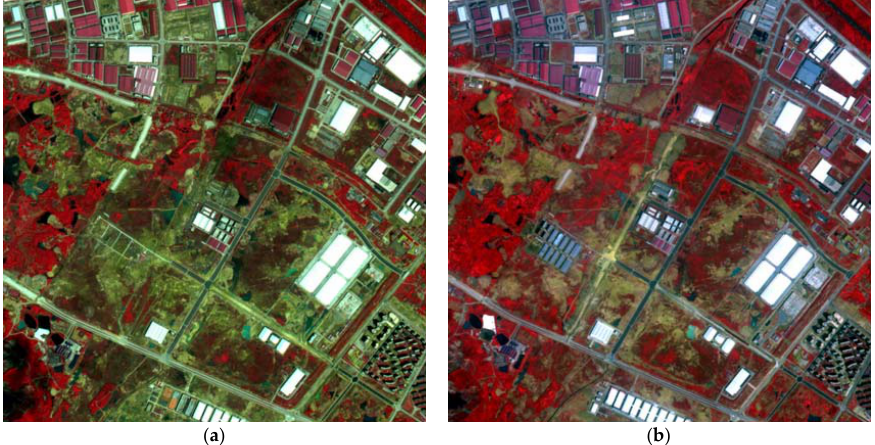
Figure 9. The pseudocolor VHR images acquired by GF-2 satellite on ( a ) 11 April 2016; and ( b ) 1 September